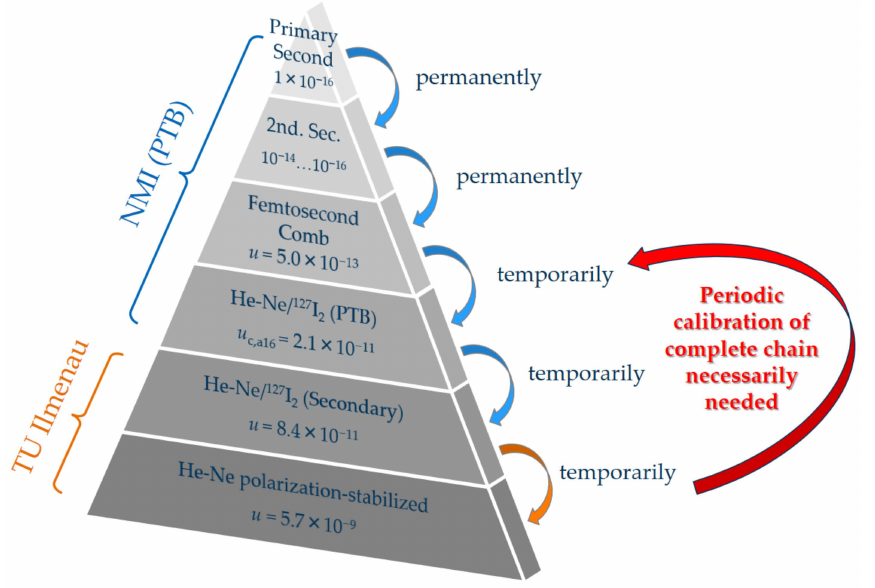
Figure 2. Scheme of a possible traceability chain for laser wavelength calibration deploying iodine- stabilized He-Ne lasers. The given uncertainties were taken from the literature as given within the